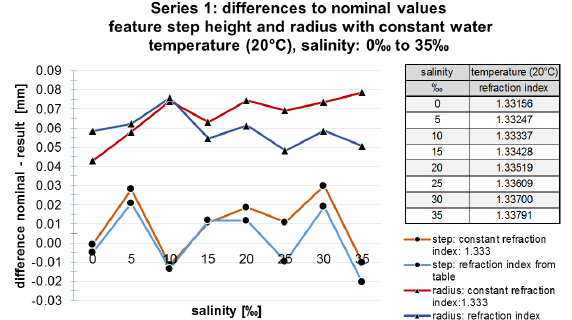
Figure 12. Results of an underwater measurement with constant temperature and increasing salinity